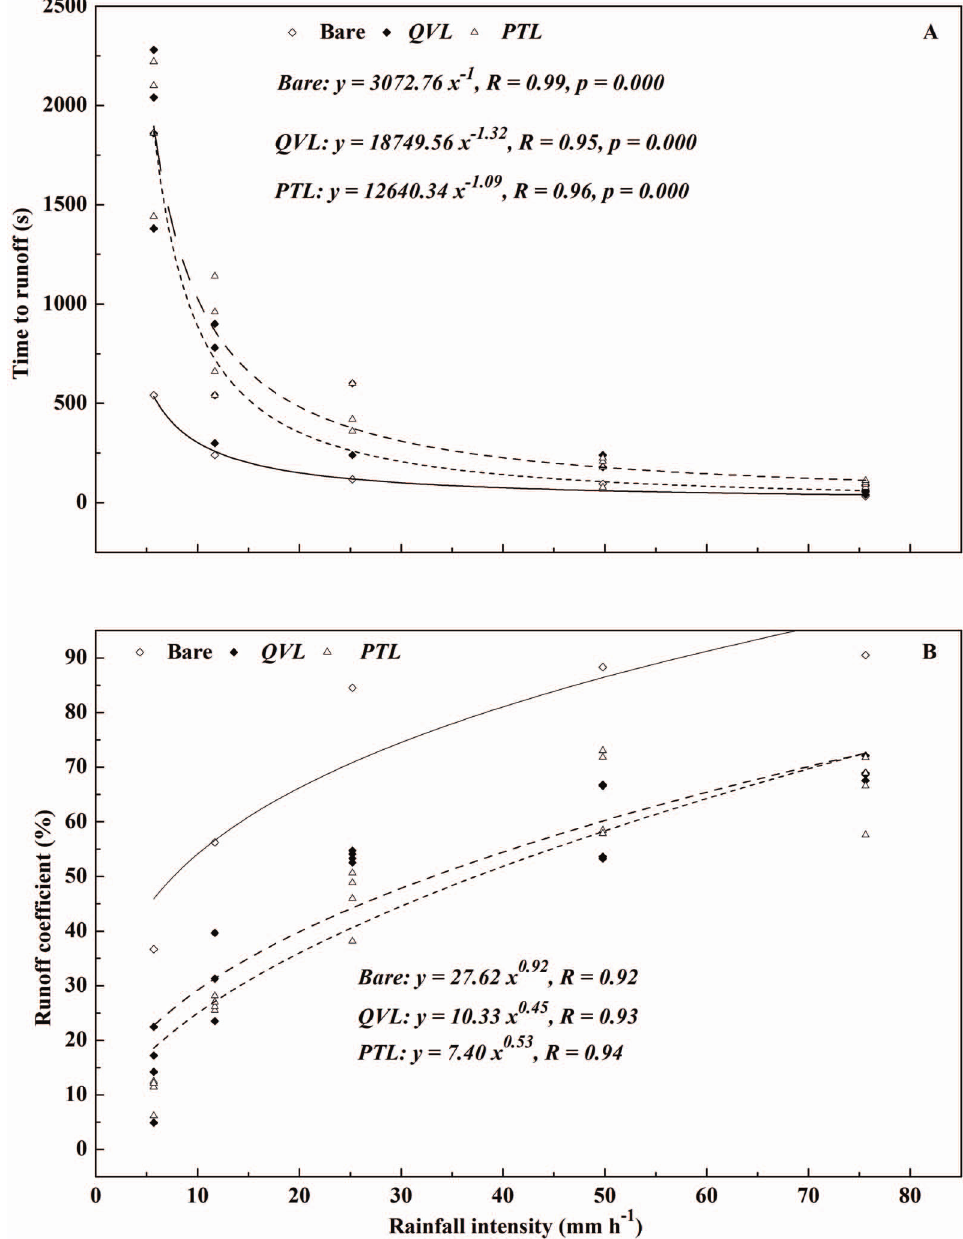
Figure 6. Rainfall intensity versus time to runoff and runoff coefficient for bare-soil plots (open diamonds), Quercusvariabilis litter (closed diamonds), and Pinustabulaeformis litter (open triangles) for four litter masses.